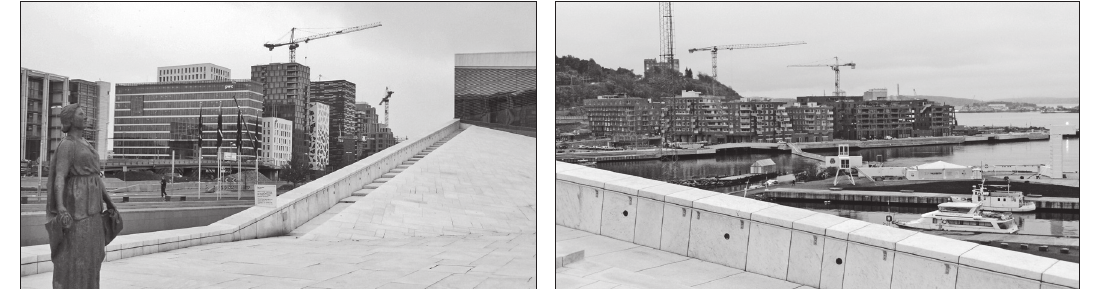
fig. 3. Port of Bjorvika conversion